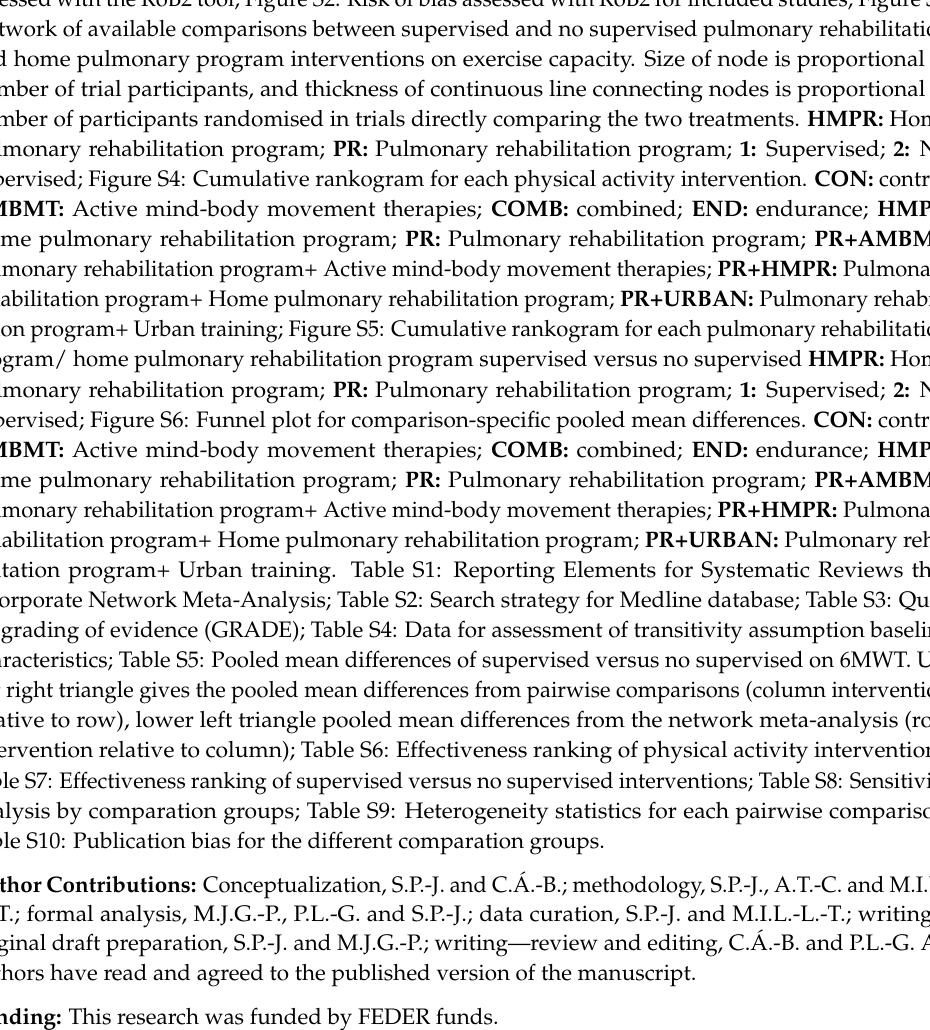
Table S7: Effectiveness ranking of supervised versus no supervised interventions; Table S8: Sensitivity Table S10: Publication bias for the different comparation